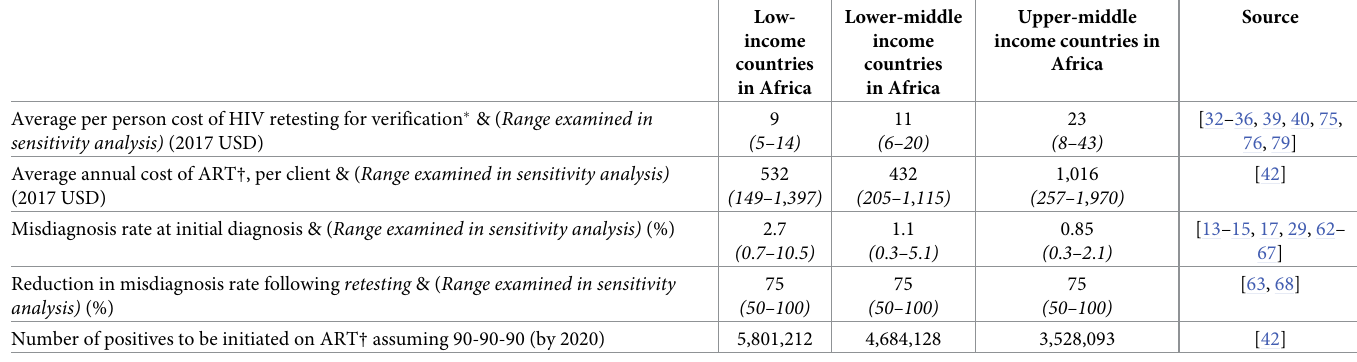
Table 3. Base-case values for model input parameters and range for sensitivity